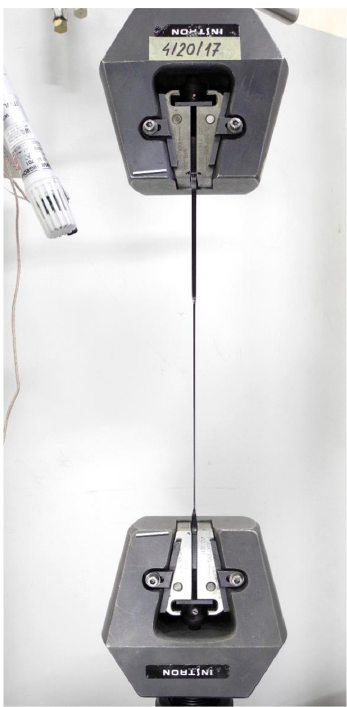
Figure 11. View of the sample fixed in the strength machine after stopping the test.